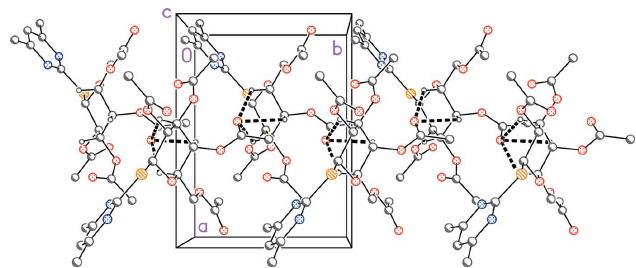
Figure 2 Packing diagram of 4 projected parallel to the ab plane in the region z ’ 1. Dashed lines indicate weak C—H (cid:4)(cid:4)(cid:4) O hydrogen bonds. H atoms not involved in this hydrogen bonding system have been